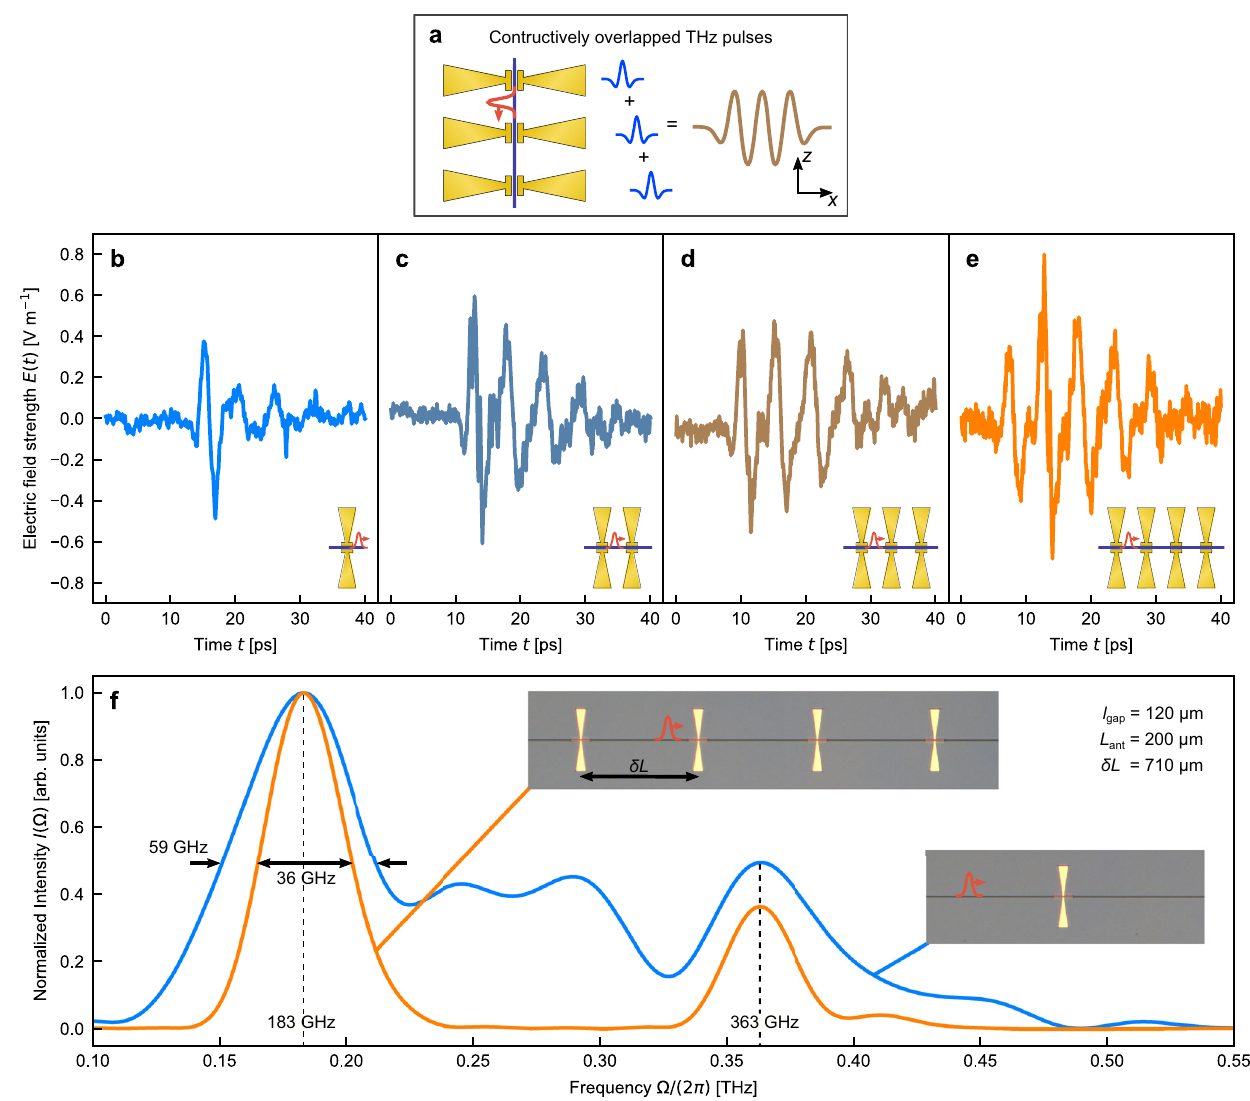
Fig. 3 | The serial block: single-THz-cycle temporal coherence synthesis. a Schematic of the proposed serial con fi guration. The input pulse pumps all antennas subsequently. The synthesized THz waveform results from the spatio- temporal superposition of all emitted single-cycle pulses enabled by low- propagation loss of the TFLN platform. This allows engineering the temporal coherence at the level of one single THz cycle. b – e Time-domain electric fi eld emittedby eachserialblock of antennas with anantenna armlength L ant =200 μ m and a gap length of l gap =120 μ m. The distance between the antennas measures δ L =710 μ m in allcases leading toa phase-shiftof2 π andconstructiveinterference